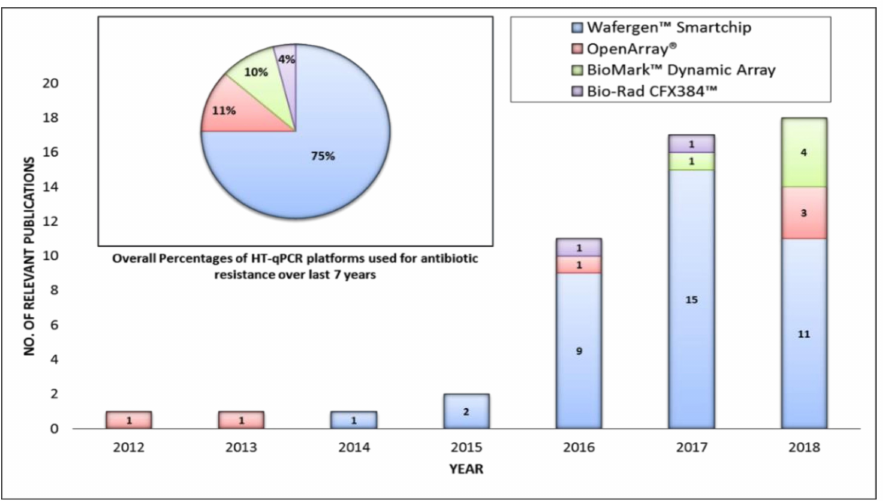
Figure 2. Number of publications using different HT-qPCR platforms over last 7